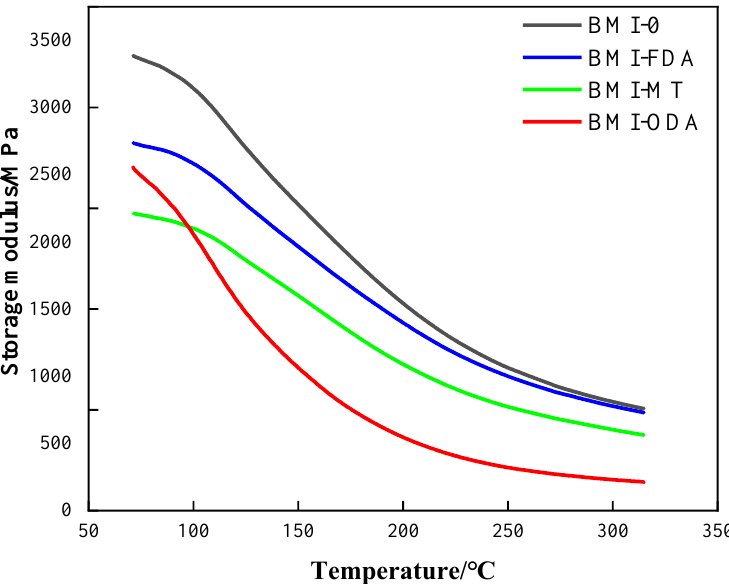
Figure 7. Storage modulus of BMI-NH2.